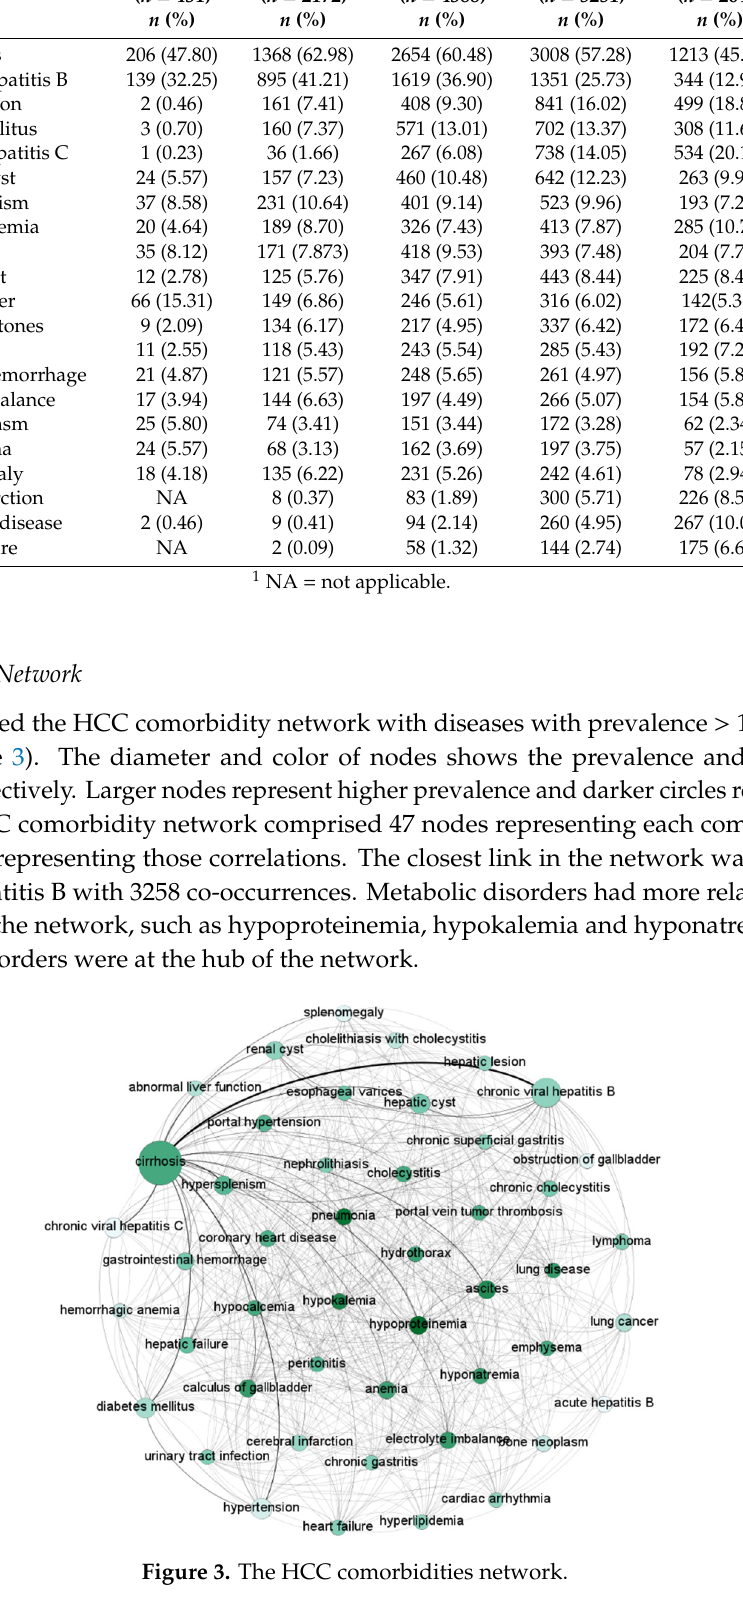
Figure 3. The HCC comorbidities network.